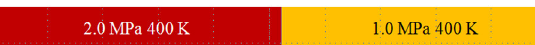
FIGURE 9 | Pressure comparisons of the HSI method and FLUENT at x = 0.2m under outlet pressure transient using laminar flow